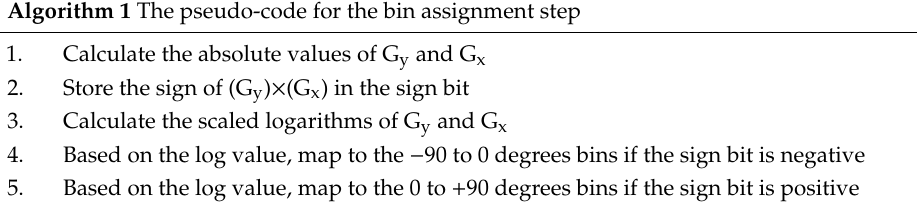
Algorithm 1 The pseudo-code for the bin assignment